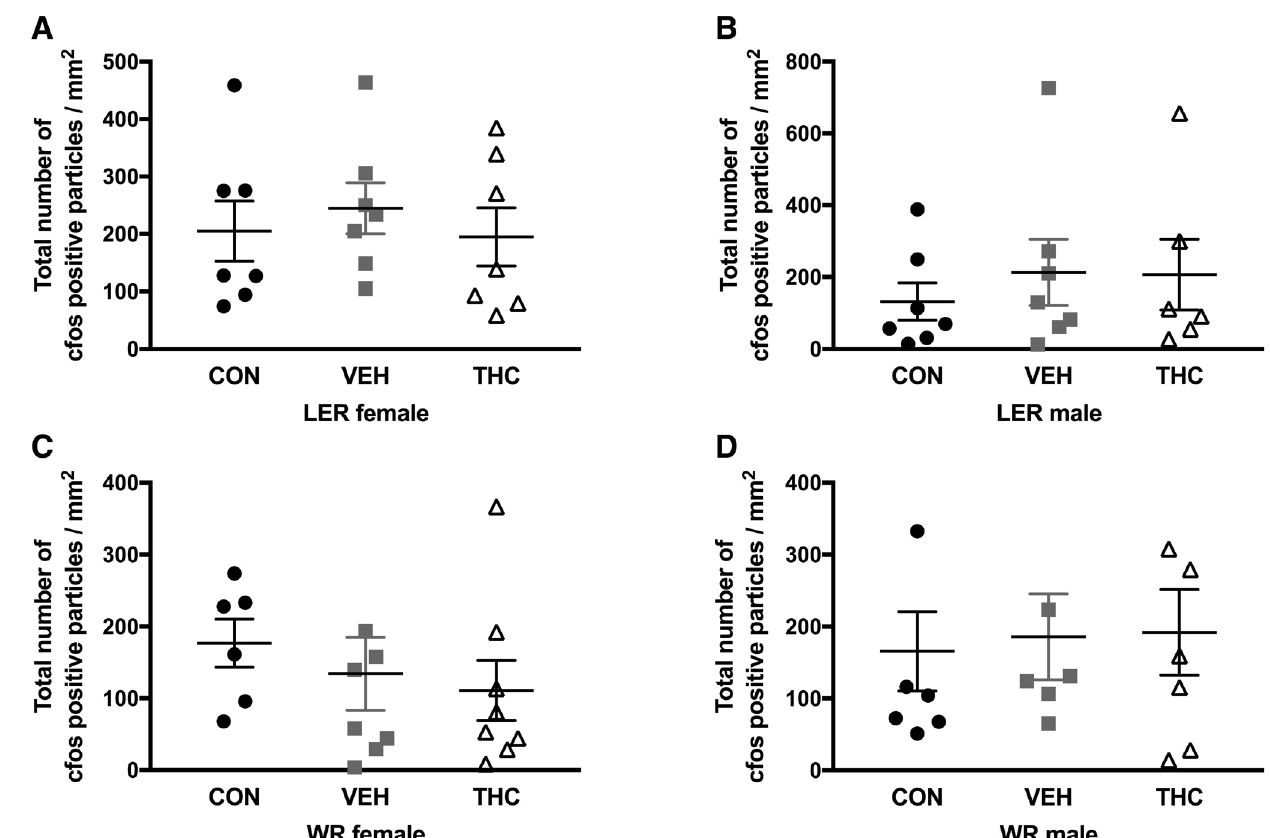
Figure 4. Cfos staining in NAc in LER and WR male and female rats exposed to THC as